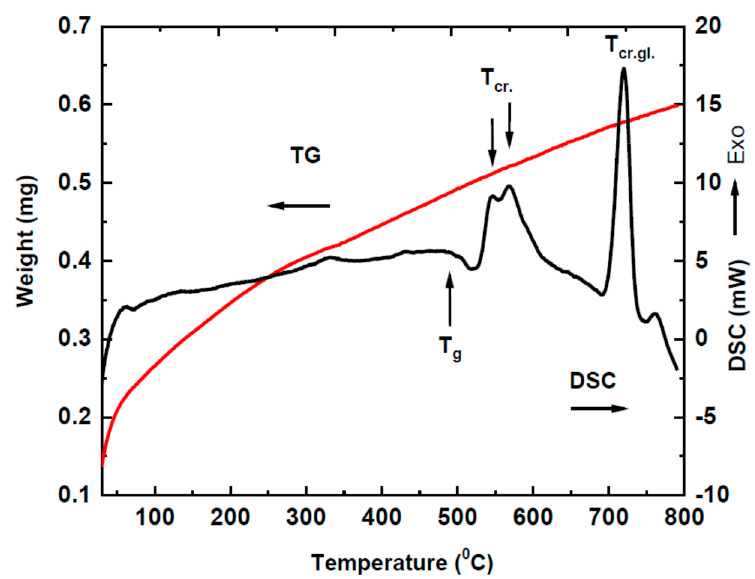
Figure 1. Thermal analysis curves of the thermogravimetry (TG)/differential scanning calorimetry (DSC) recorded on Eu-doped chloroborate glass.